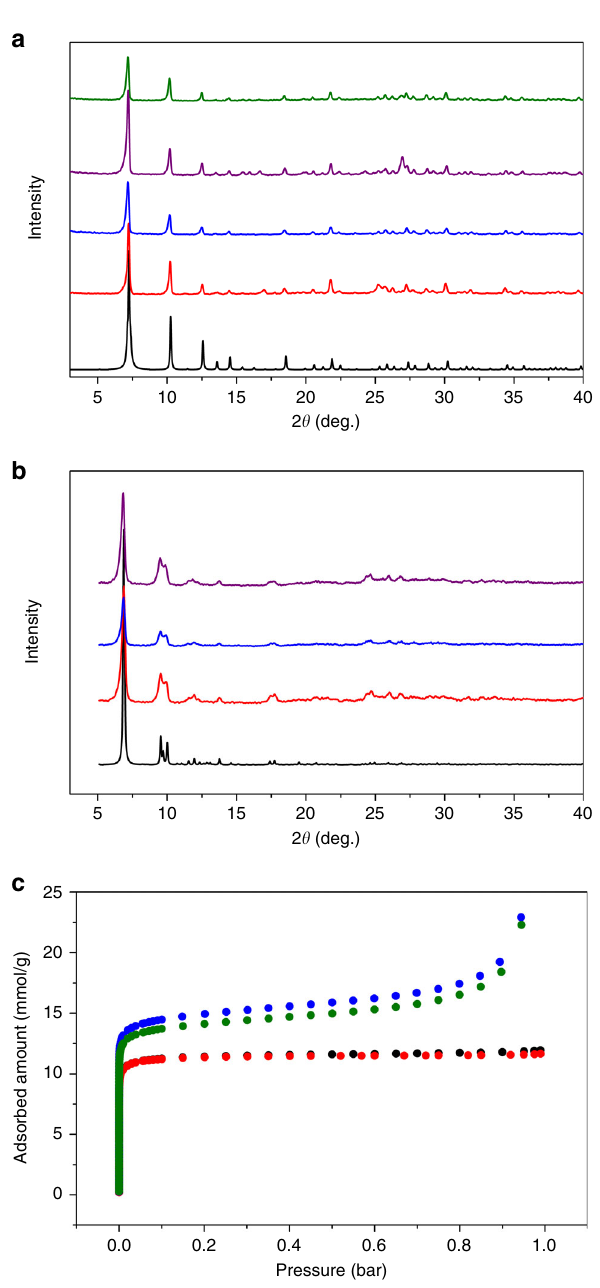
Fig. 3 Stability test and porosity characterization of compounds 1 and 2 . a Powder X-ray diffraction patterns of compound 1 . From bottom to top: simulated (black), as synthesized (red), after adsorption experiments (blue), heated at 180 °C in open air for 1 month (purple, relative humidity: ~30 – 50% RH), and boiled in water for 1 week (green). b Powder X-ray diffraction patterns of compound 2 . From bottom to top: simulated (black), as synthesized (red), boiled in water for 3 days (blue), and heated at 180 °C in open air for 1 week (purple). c N 2 adsorption isotherms at 77 K for compound 1 (as synthesized: black, after being heated at 80 °C in water for 1 day: red) and compound 2 (as synthesized: blue, after being heated at